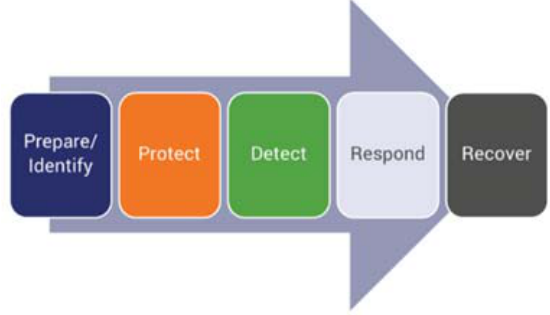
Figure 1. Five pillars for security evaluation.